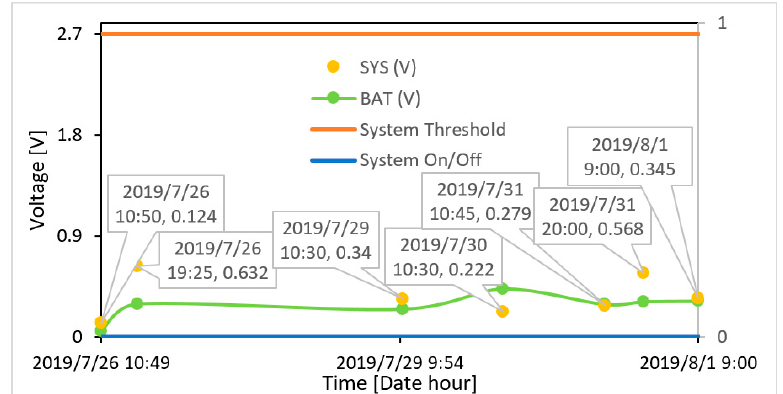
Figure 6. The voltage in the supercapacitor collected with mechanical energy. For every time that we take the measurement, there is a value for SYS (yellow points), a value for BAT (light green line) and the state of the device, called System On/Off (blue line). The system never turns on because neither SYS nor BAT reach the 2.7 V needed, which is marked by the orange line.